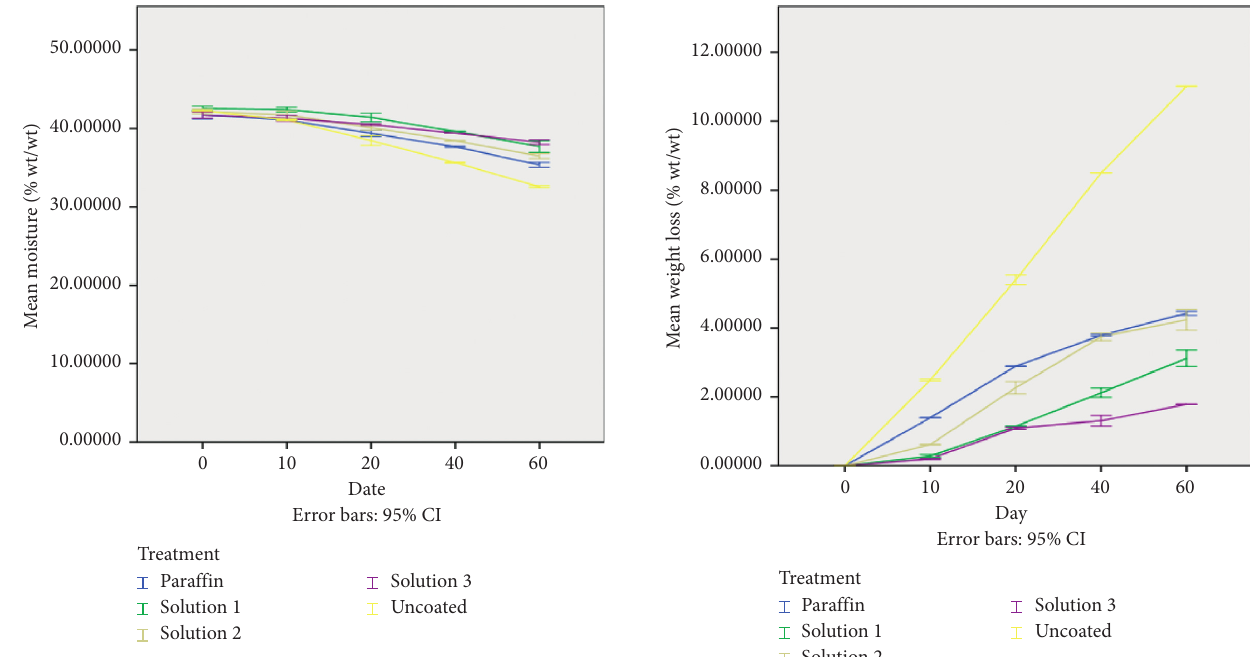
Figure 7: Values (means ± SD) of the moisture content of cheese coated with antimicrobial edible coating solutions—solution 1 (0.250 g/L Delvocid), solution 2 (0.275g/L Delvocid), and solution 3 (0.300g/L Delvocid)—compared with cheese coated with com- mercial coating and uncoated cheese throughout 60d of storage at 10 ° C and 85% relative humidity.